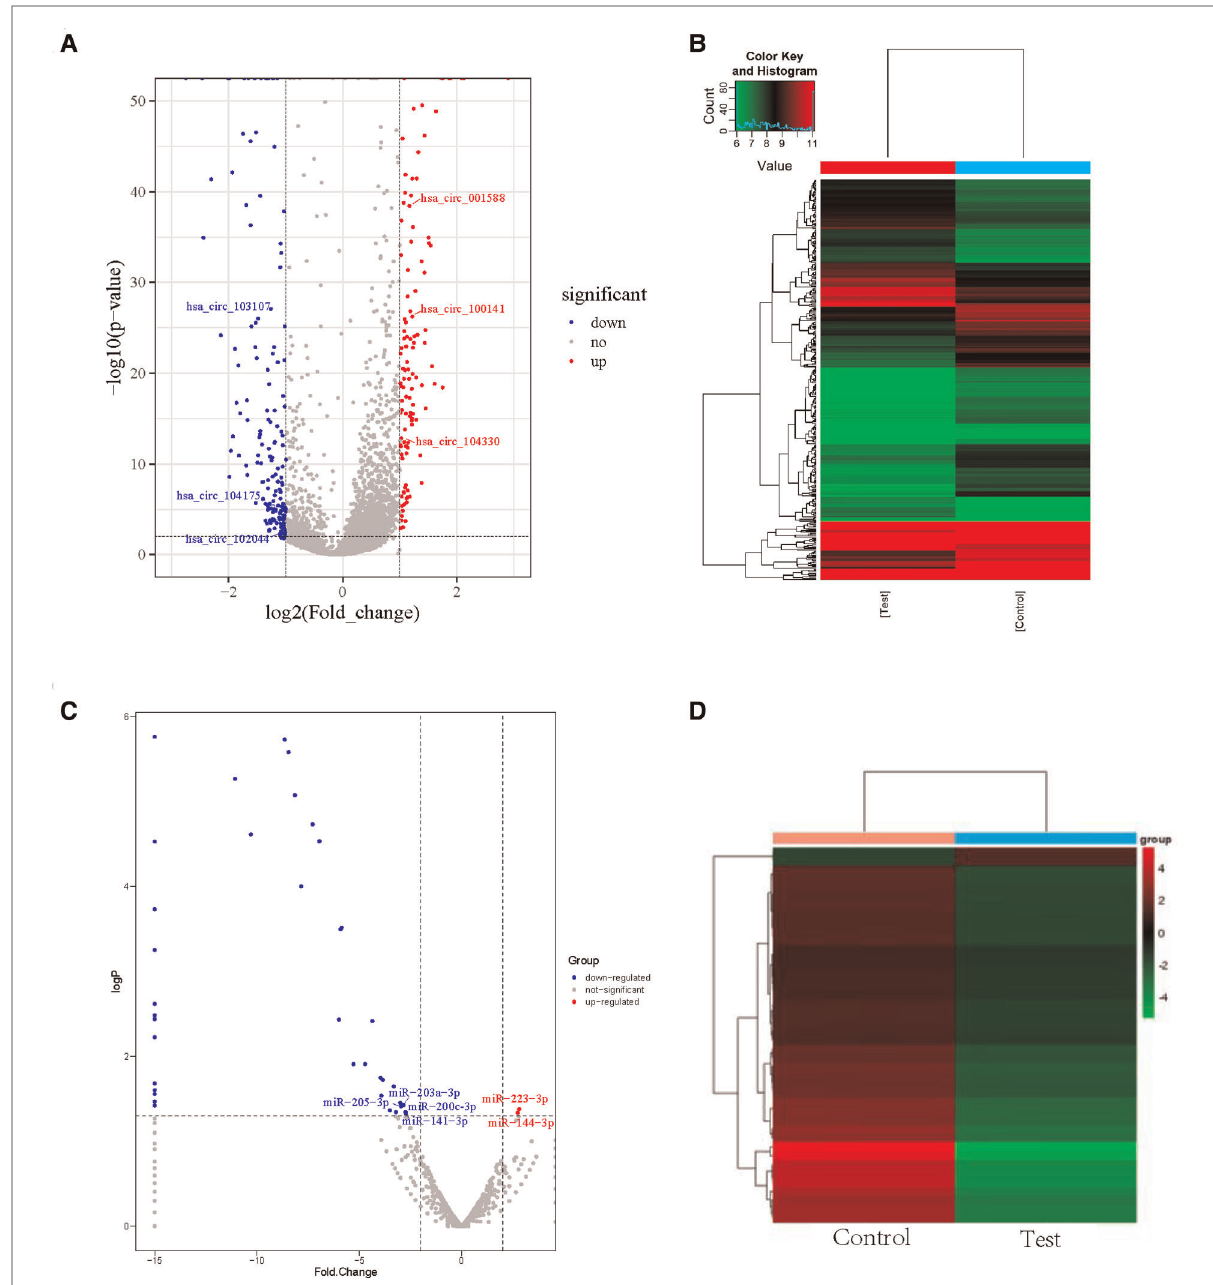
FIGURE 1 Differential cirRNAs and miRNAs expression pro fi les determined by RNA-seq. ( A ) Volcano plot of differential expression of circRNAs in wound tissues of diabetic patients. X-axis: log2 (FC); Y axis: — log10 ( p -value); X-axis parallel line: p =0.05; Y-axis parallel line: FC=2; Red region: differential genes with p <0.05 and FC ≥ 2; Blue region: differential genes with p <0.05 and FC ≤ 0.5. ( B ) Differential expression of circRNA type heat picture in wound tissues of diabetic patients. The abscissa is the sample name, and the ordinate is the probe number. Black indicates that the gene expression level has not changed, red indicates that the expression level increases, and green indicates that the expression level decreases. The brightness of the color represents the degree of increase or decrease in gene expression. ( C ) The volcano plot visualizes the expression of miRNAs between chronic diabetic wound tissues and adjacent normal skin tissues (NC: normal tissue, Case: wound tissue) X axis: Log2 (FC); Y axis: — log10 ( p- value); X-axis parallel line: p =0.05; Y-axis parallel line: FC=2; Red region: differential genes with p <0.05 and FC ≥ 2; Blue region: differential genes with p <0.05 and FC ≤ 0.5. D. Differential expression of miRNA type heat picture in wound tissue of diabetic patients. The abscissa is the sample name and the ordinate is the probe number. Black indicates that the gene expression level has not changed, red indicates that the expression level increases, and green indicates that the expression level decreases. The brightness of the color represents the degree of increase or decrease in gene